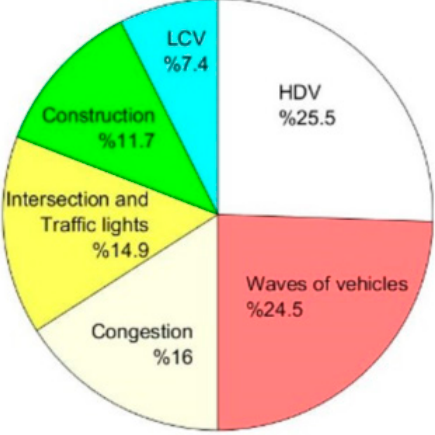
Figure 12. The percentage of each contributor to the spikes.